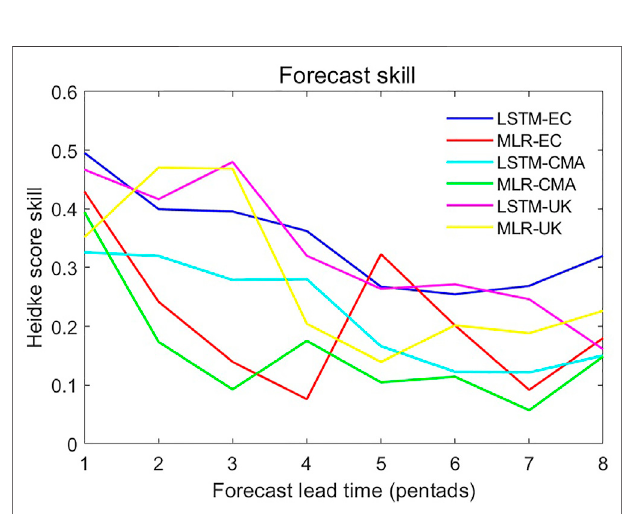
FIGURE 9 | Heidke Skill Score ( y -axis) of MLR and LSTM PM 2.5 concentration predictions based on CMA, U.K., and ECMWF models with different period validity (one to eight pentads) ( x